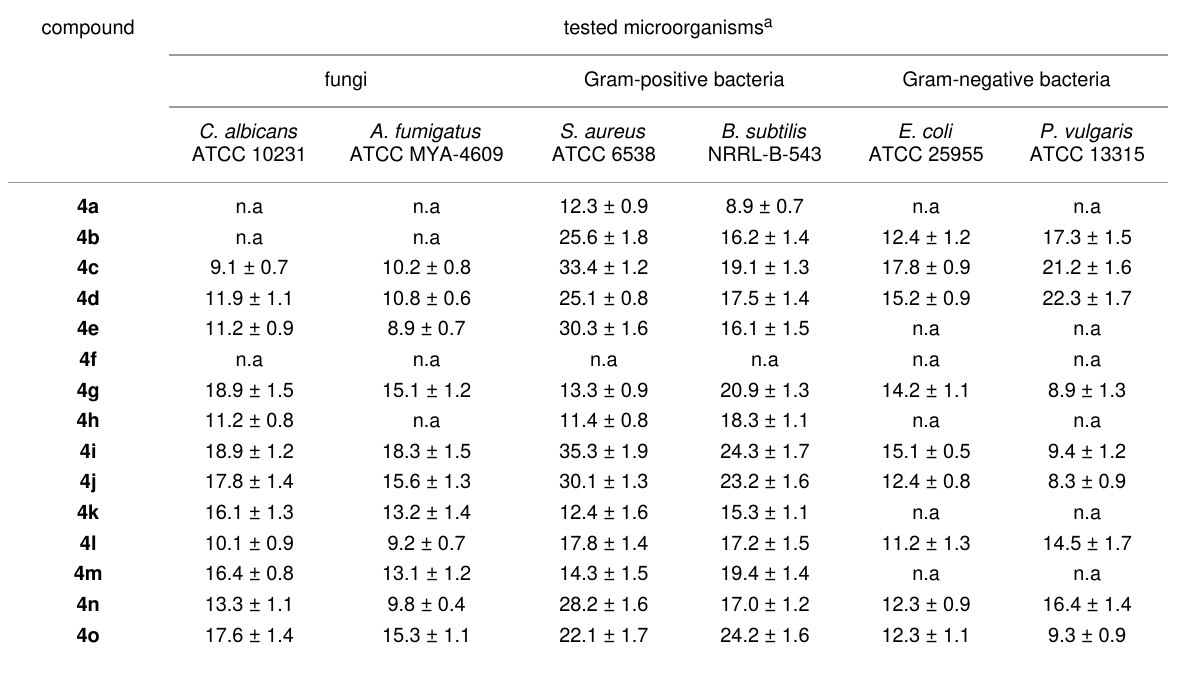
Table 1: In vitro antimicrobial activities of the synthesized compounds tested at 10 mg/mL by modified well diffusion agar method and expressed as mean inhibition zone diameter (mm).